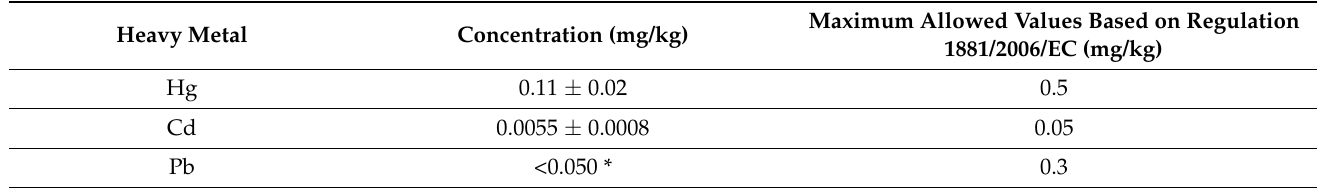
Table 4. Concentrations of heavy metals (mg/kg wet weight), in Cyprinus carpio flesh from Bogdanas River. Heavy Metal